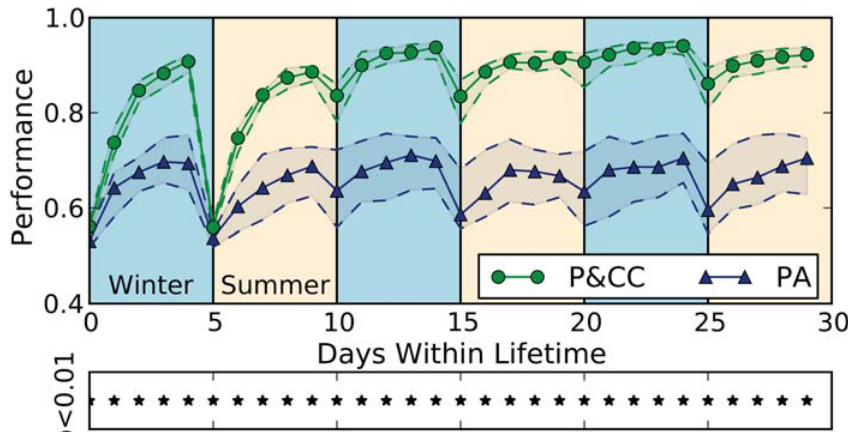
Fig 5. Performance each day for evolved agents from both treatments. Plotted is median performance per day ( ± 95% bootstrapped confidence intervals of the median) measured across 100 organisms (the highest-performing organism from each experiment per treatment) tested in 80 new environments (lifetimes) with random associations (Methods). P&CC networks significantly outperform PA networks on every day (asterisks). Eating no items or all items produces a score of 0.5; eating all and only nutritious food items achieves the maximum score of 1.0.